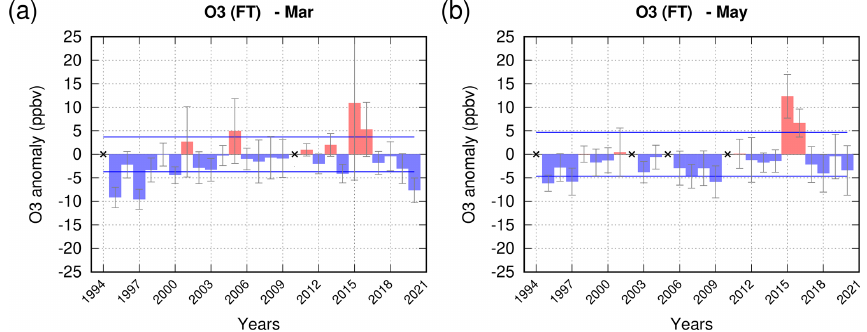
Figure 7. Anomalies of ozone for 1994–2020 for the months of (a) March and (b) May in the free troposphere (850–350hPa). There were no ozone data in April 2020. The grey bars represent the 95% confidence limits, and the blue horizonal lines represent the interannual